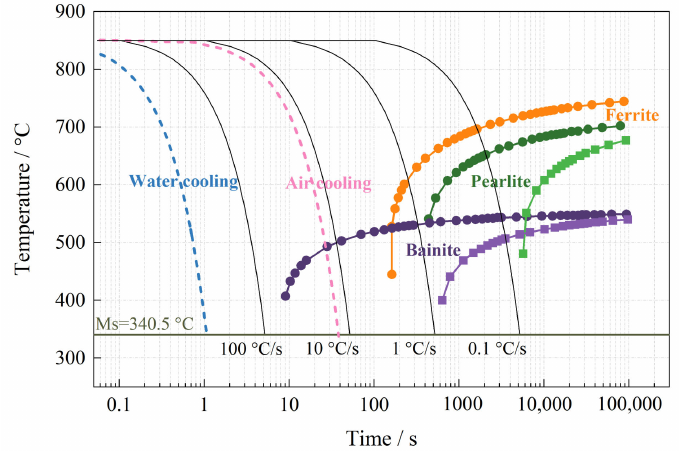
Figure 2. CCT curves of the sucker rod steel calculated by the JMatPro